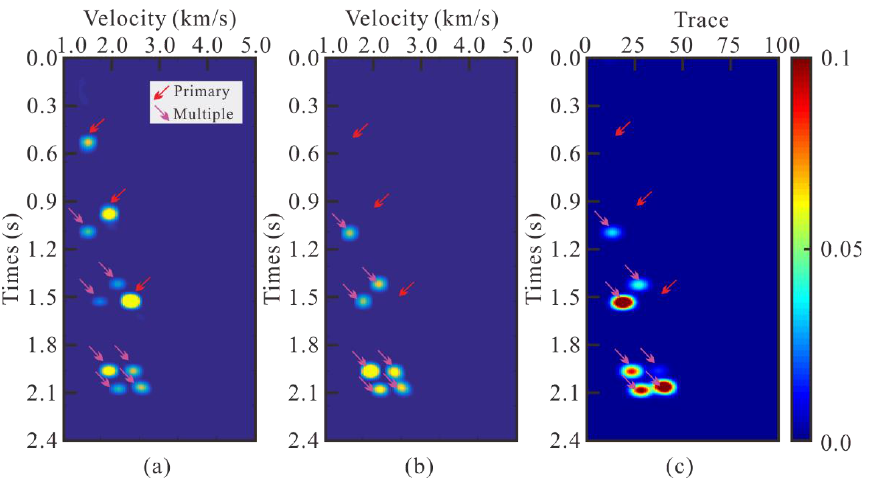
Figure 2. A demonstration of the similarity between the original data velocity spectra and the pre- dicted multiple velocity spectra: ( a ) the velocity spectra of original data. ( b ) The velocity spectra of predicted multiples. ( c ) Local similarity spectra.